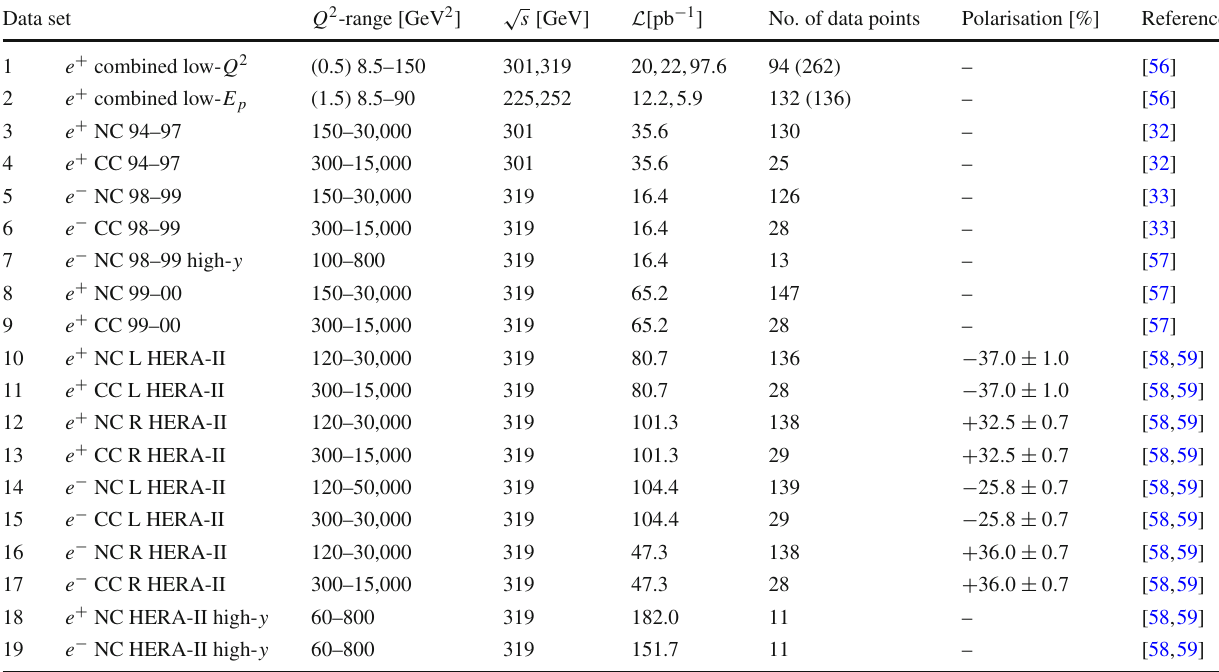
Table 1 Data sets used in the combined EW and QCD fits. For each of the data sets, the corresponding range in Q 2 , the centre-of-mass energy √ s ,thecorrespondingintegratedluminosityvalues,thenumberofmea- sured data points, and the average longitudinal polarisation values of the lepton beam are given. During the HERA-I running period data were taken with unpolarised lepton beams. The numbers in brackets denote the respective quantities for the full data set, i.e. without the